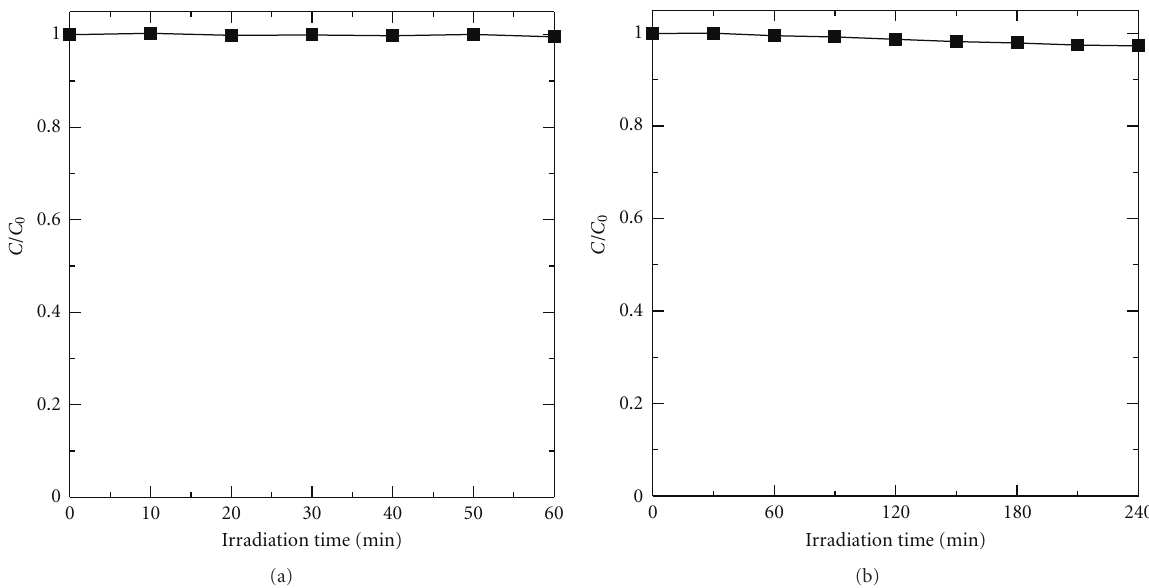
Figure 6: Changes of the MB concentrations decomposed by the C 60 as a function of (a) UV irradiation time (1.0mW/cm 2 ), (b) visible light irradiation time (10,000 lx).